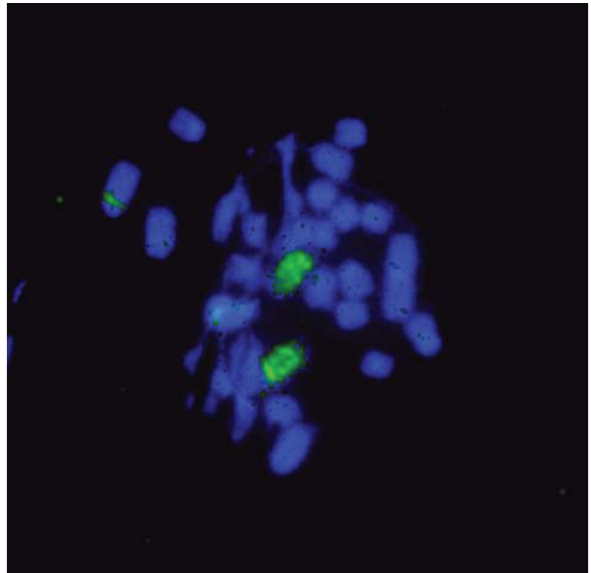
Figure 1 - Hybridization of a probe developed from a single micro- dissected autosome of Eigenmannia sp.